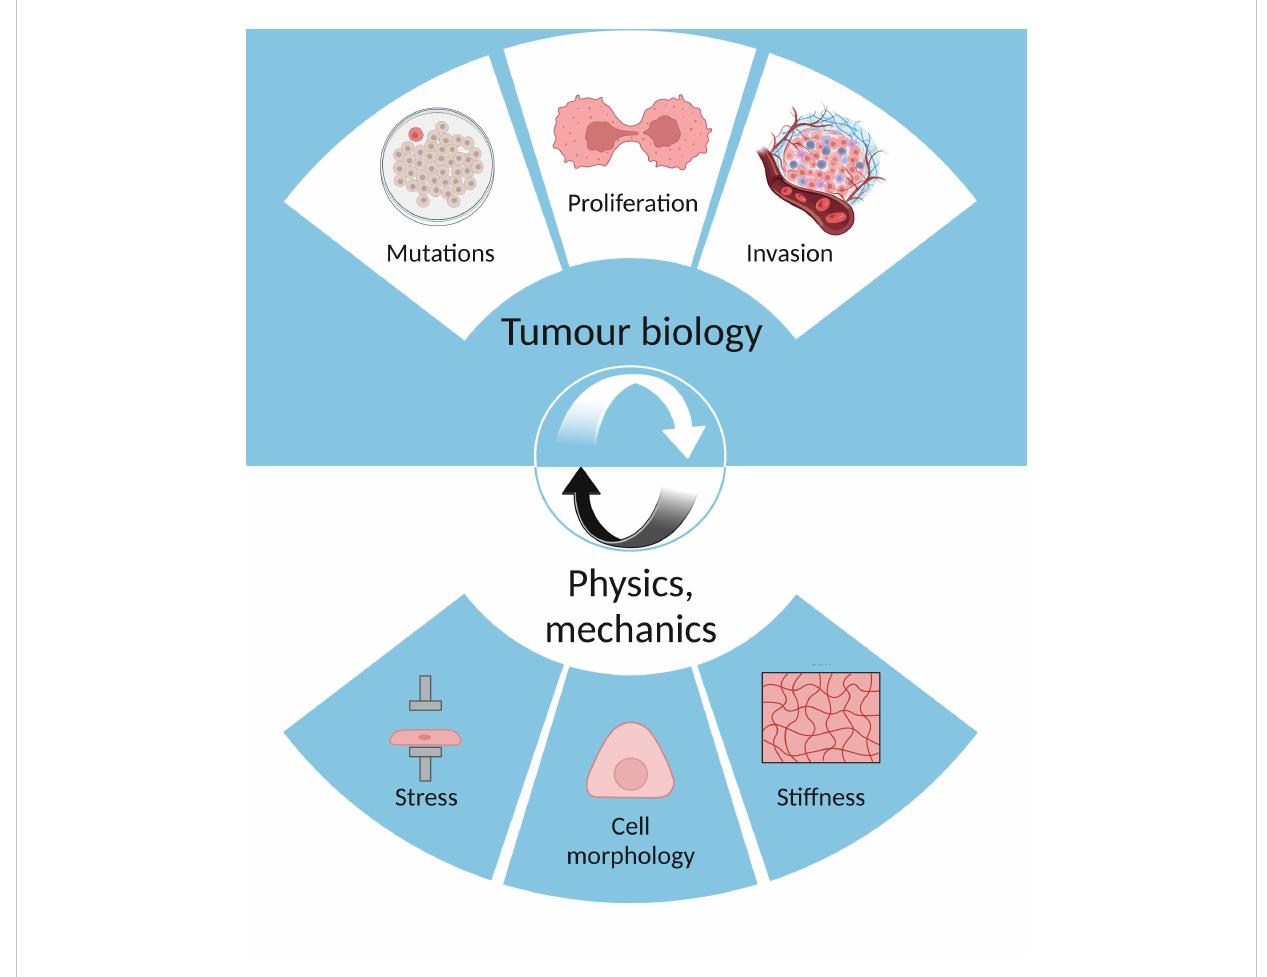
FIGURE 1 The interplay between tumour biology (mutations, proliferation, invasion) and physics (stress, cell morphology,